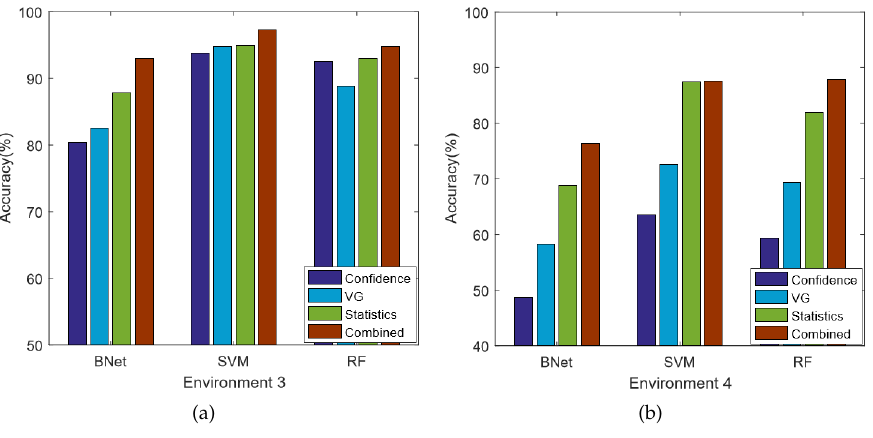
Figure 13. The impact of human